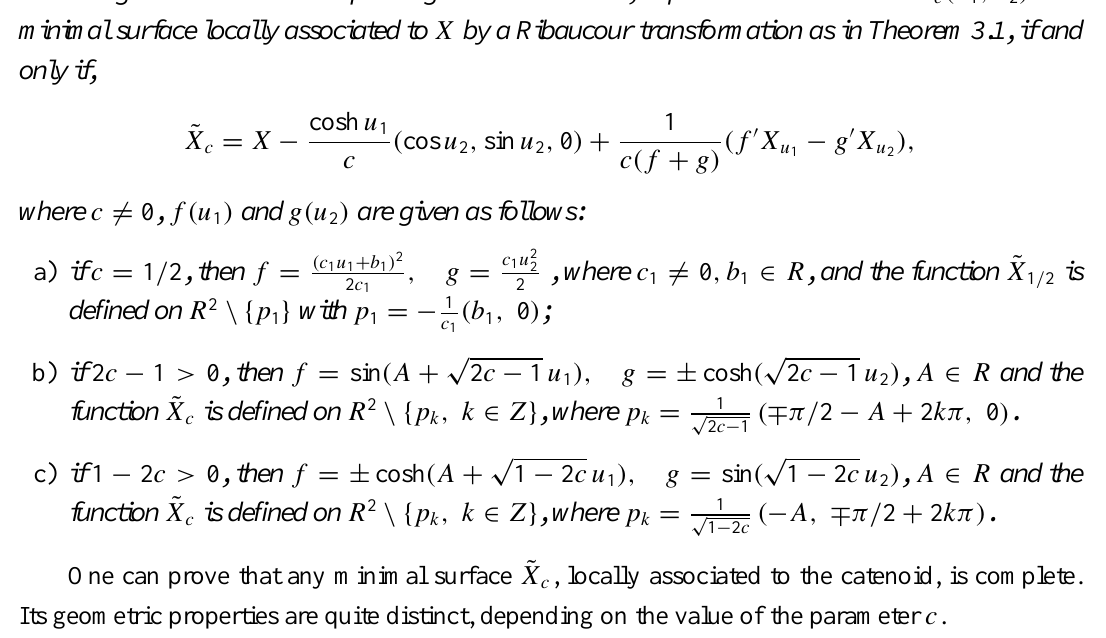
ends (see Jorge and Meeks 1983 for minimal surfaces with any finite number of catenoid